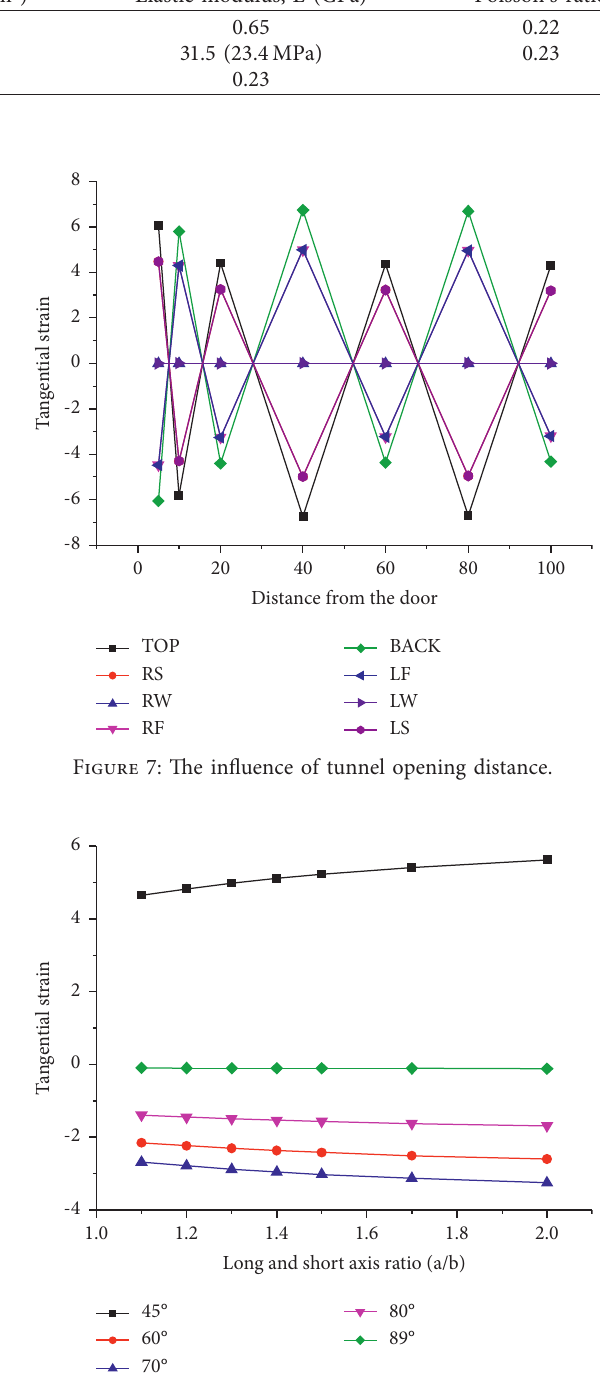
Figure 8: The influence of the long and short